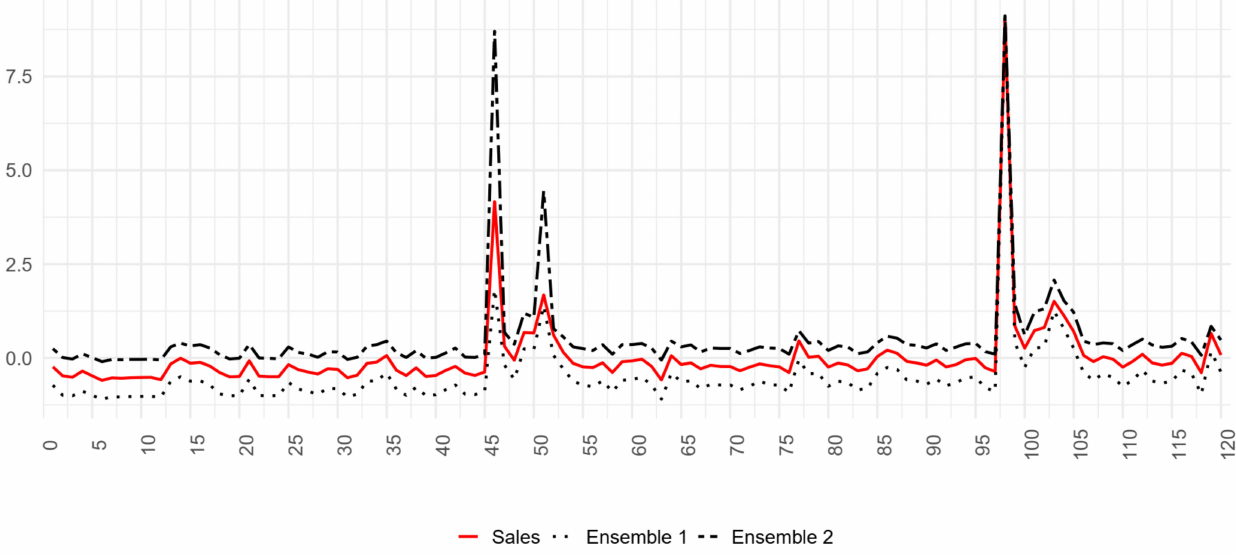
Figure 1. Plot of the standardized EUR series of web sales data used in this research, explained in the next section, and two random